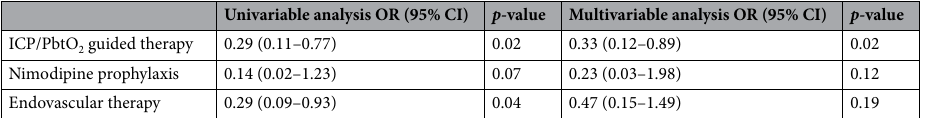
Table 3. Logistic regression analysis to identify possible association between combined ICP/PbtO 2 guided therapy and 6-month unfavorable neurologic outcome in patients undergoing ICP- or ICP/PbtO 2 guided- therapy (n = 102). Data are reported as odds ratio (OR) and 95% confidence intervals (CIs). ICP intracranial hypertension, PbtO 2 brain tissue